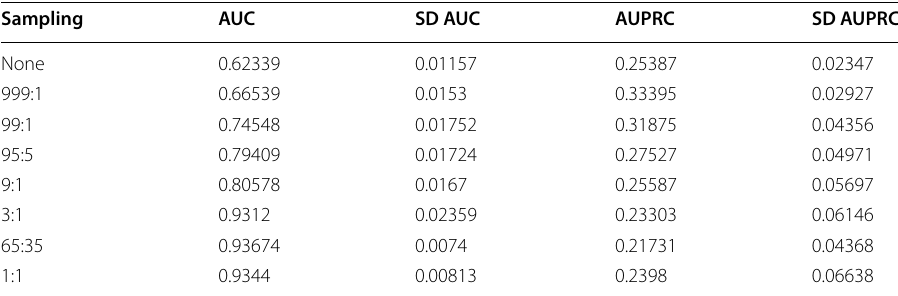
Table 10 Results for